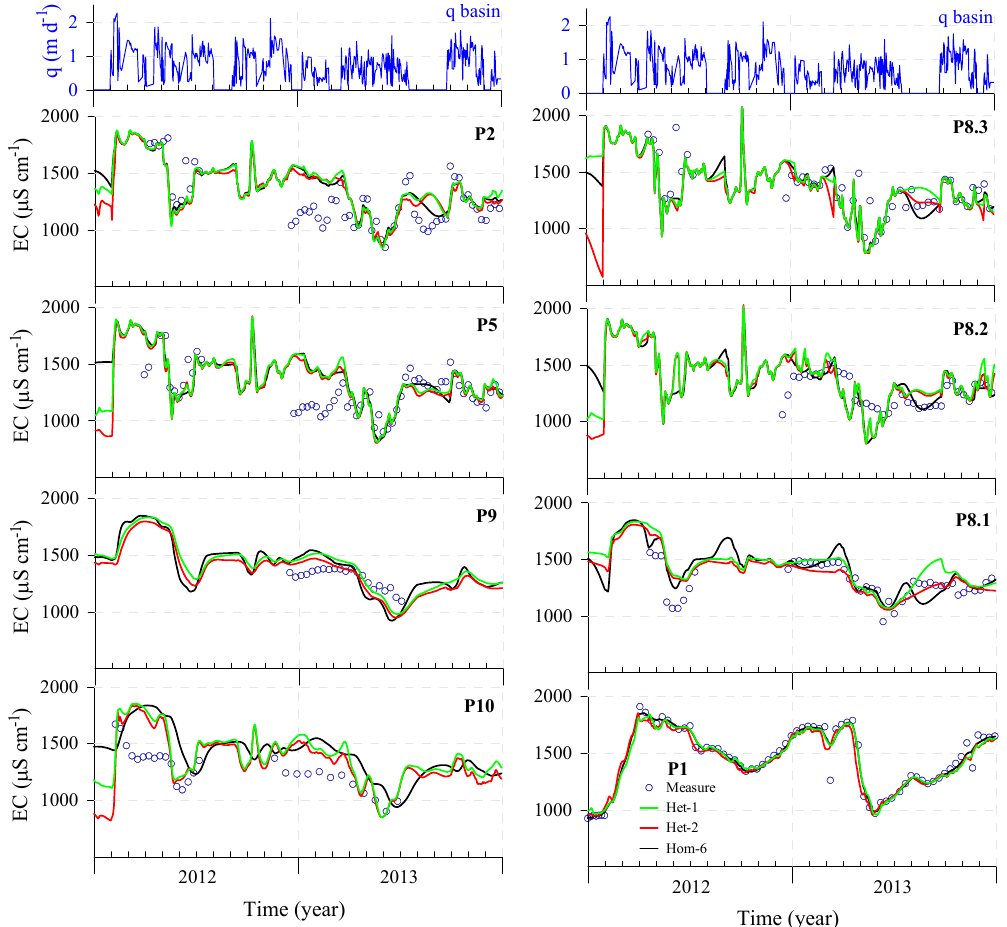
Figure 6. Changes in measured (dark blue circles) and calculated (µScm − 1 ) EC at monitoring piezometers for the Het-1 (green line), Het-2 (red line), and Hom (black line) models. The infiltration rate is also shown (top).